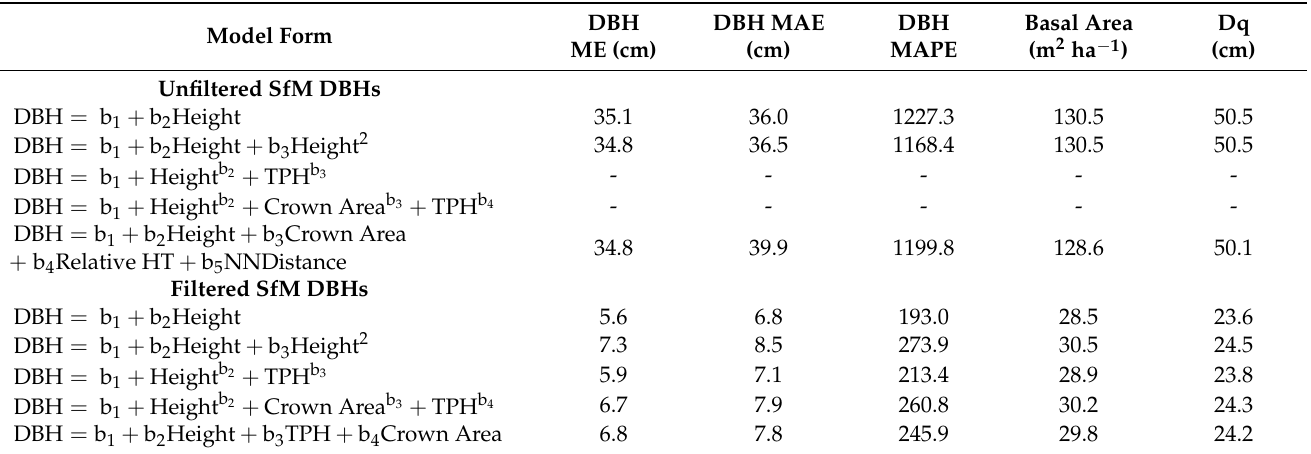
Table 2. Tree and stand scale Model prediction performance compared to the stem mapped